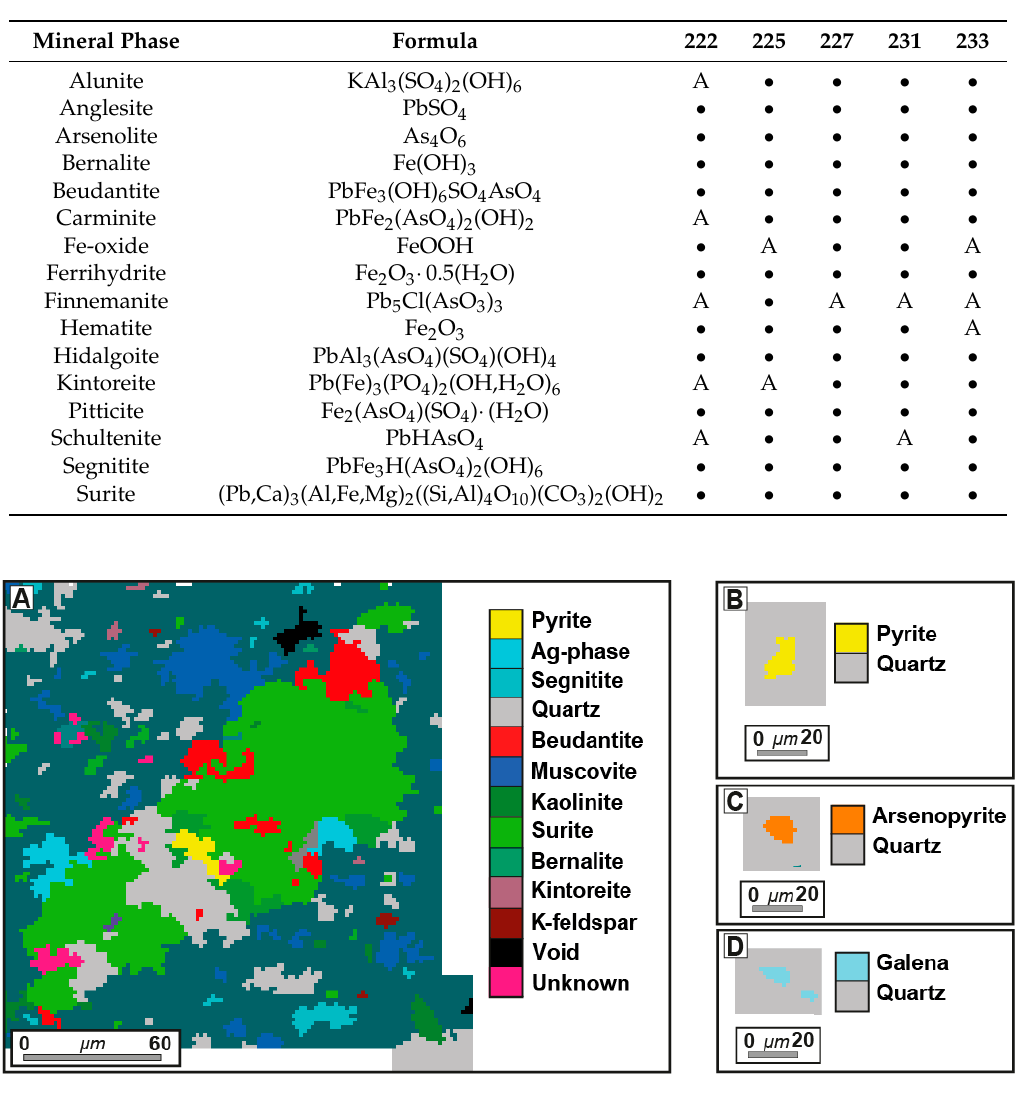
Figure 4. Classified mineralogy images showing: ( A ) anhedral pyrite with complex mineral associations (including surite, kaolinite, quartz and an unknown phase, likely iron oxide); ( B ) fine grained pyrite encapsulated in quartz; ( C ) fine grained arsenopyrite encapsulated in quartz and ( D ) fine grained galena encapsulated in quartz. Table 1. Secondary mineral phases identified by mineral liberation analysis (•—present; A—absent).